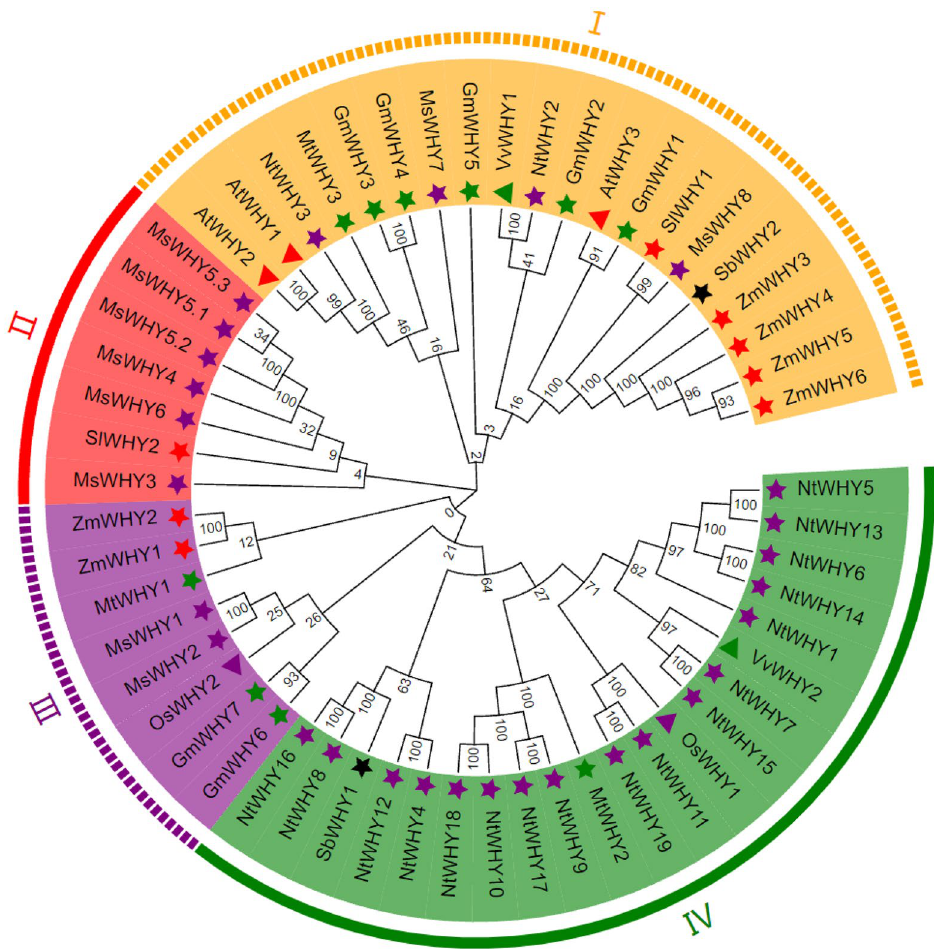
Figure 1. Phylogeny of the MsWHY gene family. The phylogenetic tree of the MsWHY gene family was constructed using all 46 WHY genes of Arabidopsis thaliana (At), Oryza sativa (Os), Nicotiana tabacum (Nt), Medicago sativa (Ms), Zea mays (Zm), Medicago truncatula (Mt), Glycine max (Gm), Solanum Lycopersicum (Sl), Vitis vinifera (Vv), and Sorghum bicolor (Sb) as outgroup. The subfamilies of the MsWHY gene family are indicated by I, II, III, and IV. The number nearby each cluster indicates the bootstrap confidence of the cluster in percentage (%).